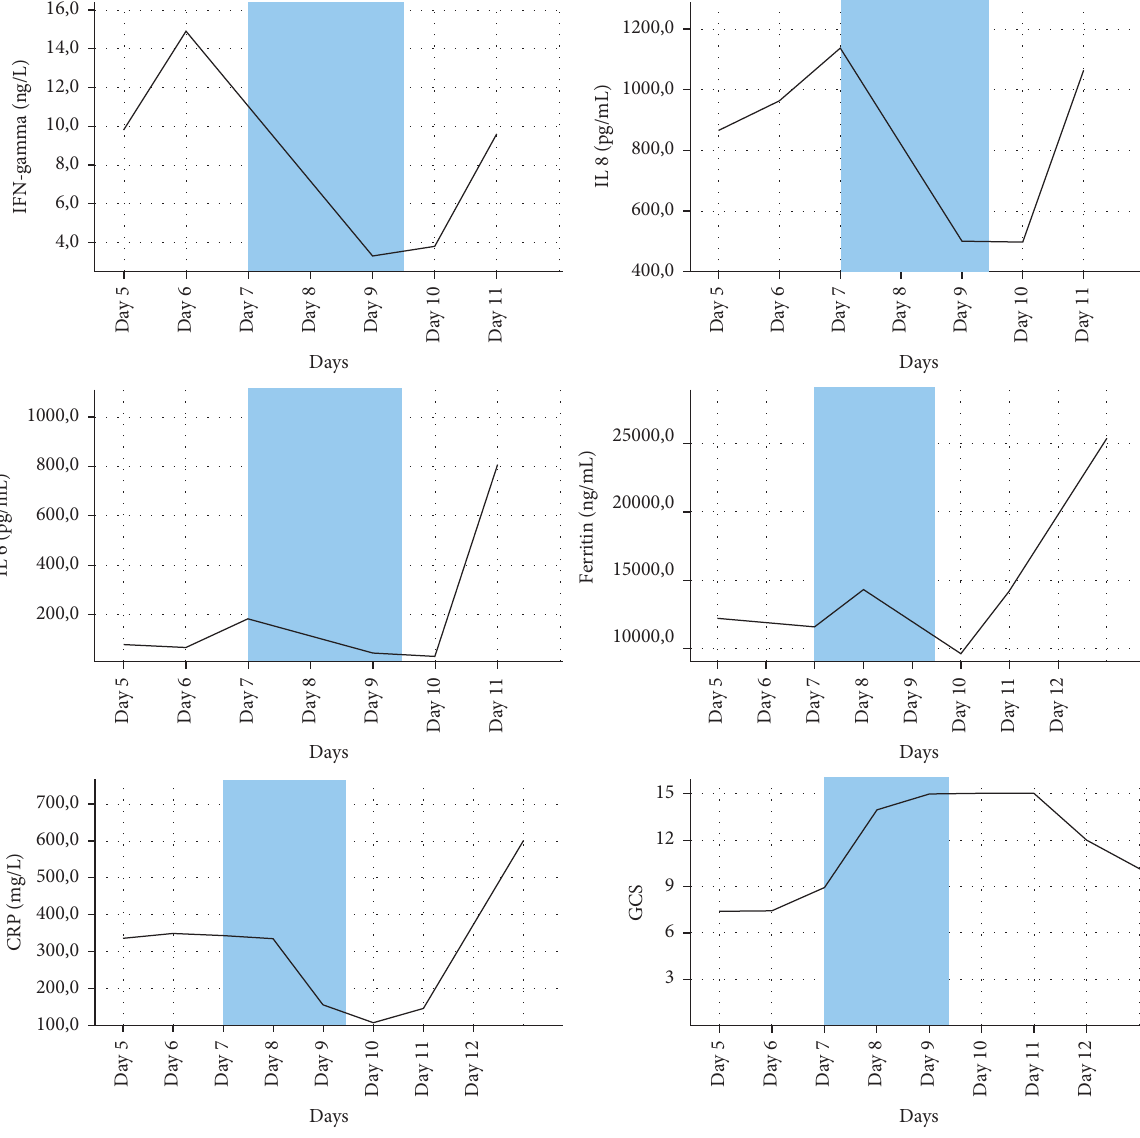
Figure 2: Temporal evolution of clinical and biological data: temporal evolution of IFN-gamma, interleukin (IL) 6 and IL8 cytokines’ serum values, biological data like ferritin, C-reactive protein (CRP), and clinical data such as Glasgow Coma Scale (GCS). Days refer to the day of ICU treatment. Shaded blue areas are the days of CytoSorb ® adsorbent application through